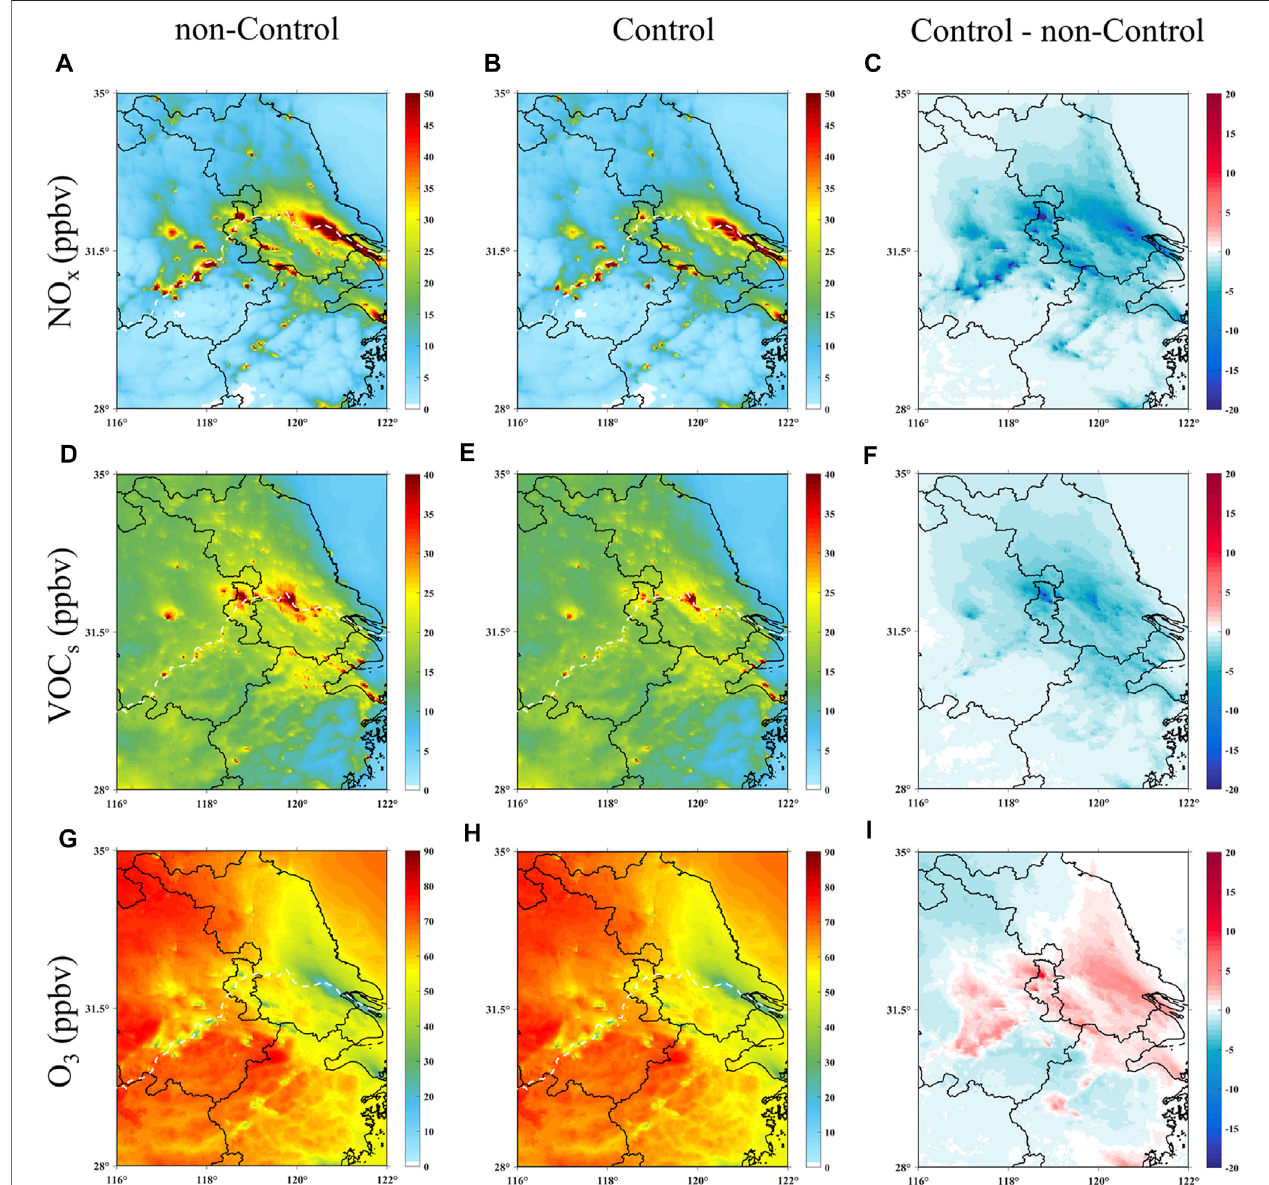
FIGURE 6 | The spatial distribution of the simulated (A – C) NO x , (D – F) VOC s and (G – I) O 3 in the non-Control or Control scenarios and their differences.